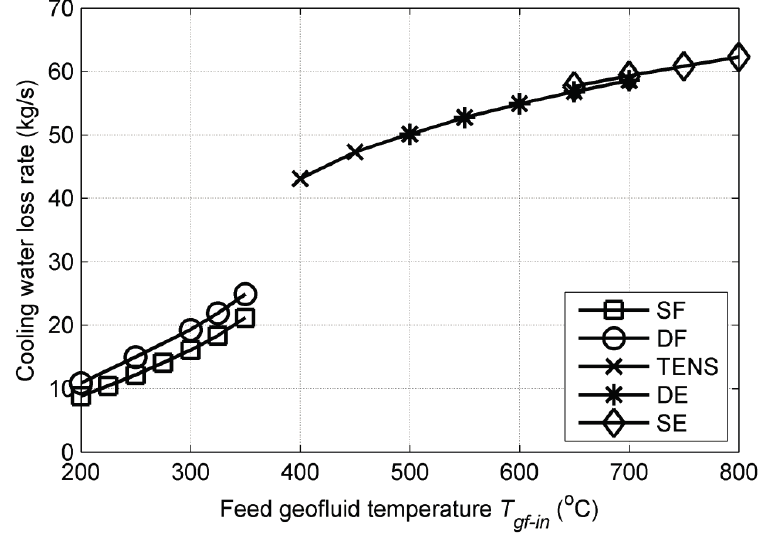
Figure 3. Water-cooled plant cooling water loss rate with respect to T gf_in for different plant configurations. SF: single flash; DF: double flash; TENS: triple expansion without superheating; DE: double expansion; SE: single